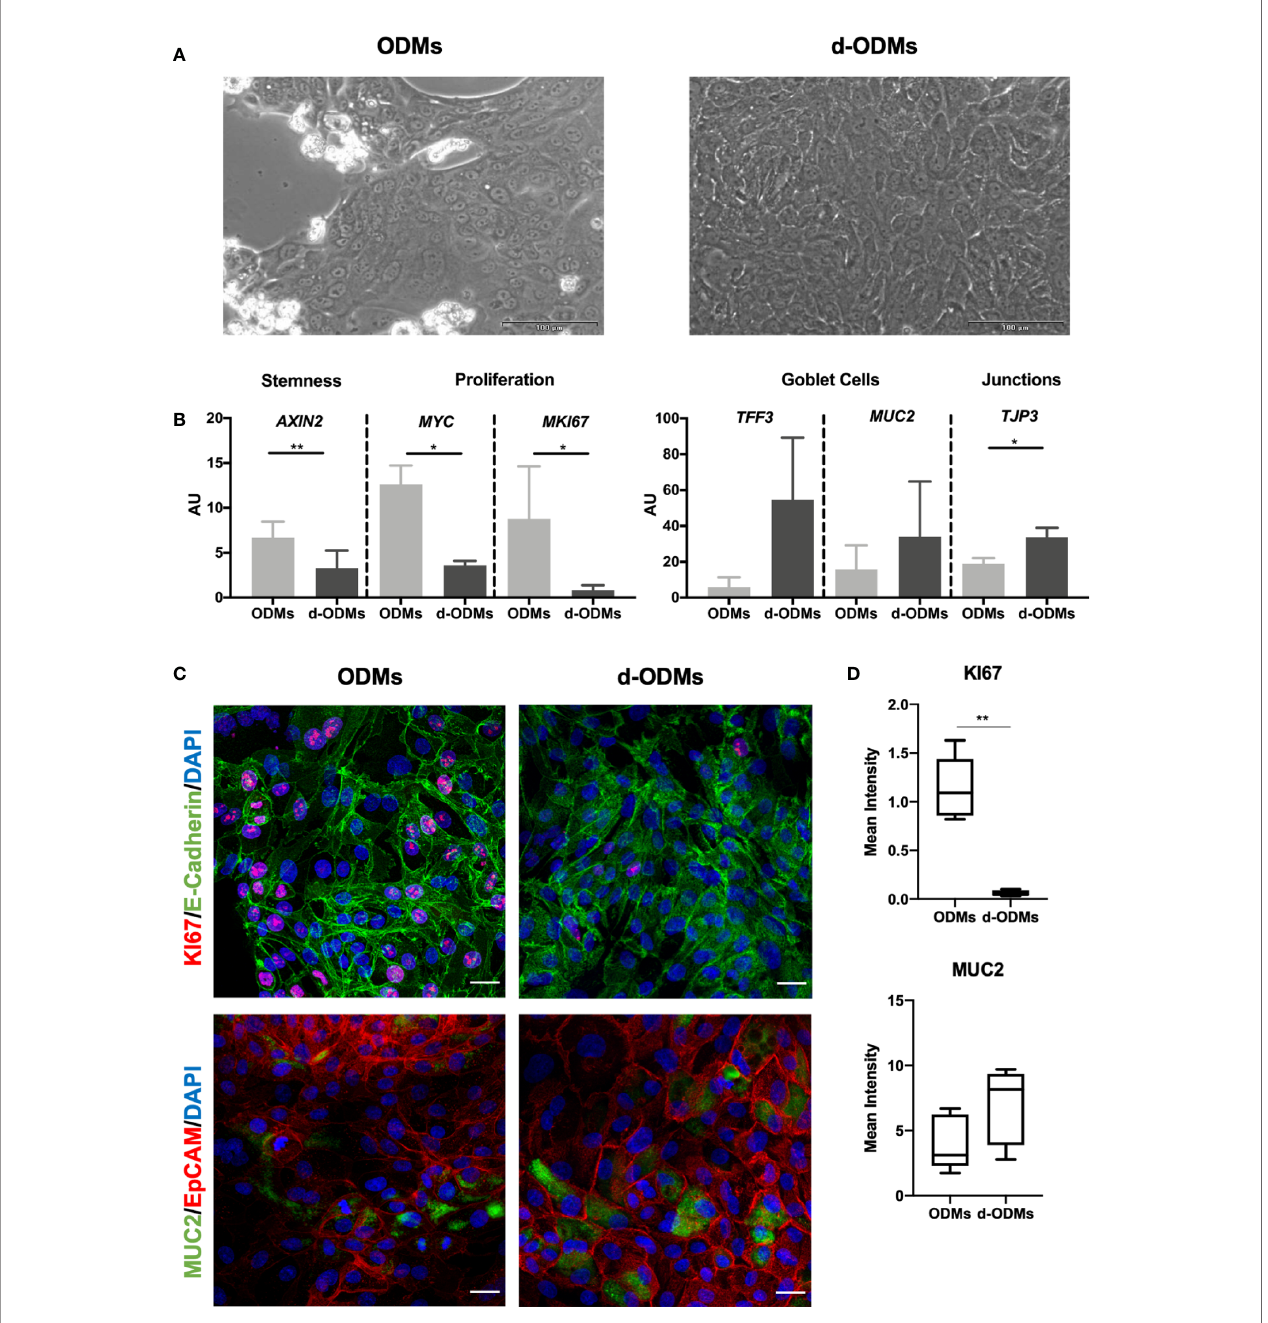
FIGURE 2 | Organoid-Derived Monolayers (ODMs) characterization. (A) ODMs (left panel) 24 hours after seeding showed a con fl uence of around 70-80% and d- ODMs (right panel) 48 hours after differentiation, showed 100% con fl uence. (B) Gene expression analysis of ODMs and d-ODMs (n = 5 for each culture type). AXIN2, MYC, MKI67, TFF3 , MUC2 and TJP3 genes were analyzed by qPCR to determine their expression levels in ODM vs. d-ODMs. A paired t-test was performed to examine statistically different expression patterns between the two groups (ODMs/d-ODMs). A P value of <0.05 was considered statistically signi fi cant. AXIN2 : **indicates P = 0.0012. MYC : *indicates P = 0.0135. MKI67 : *indicates P = 0.0335. TJP3 : *indicates P = 0.0365. (C) Protein expression analysis by immuno fl uorescence. KI67 and MUC2 were analyzed to con fi rm the proliferation and differentiation status of both ODMs and d-ODMs. E-Cadherin and EpCAM were used as epithelial cell-wall markers. DAPI was used to counterstain the cell nuclei. Scale bars: 25µm. Images are representative of n = 3 independent experiments performed with samples from two different donors. (D) Box-plot distribution of the fl uorescent signal of KI67 and MUC2 proteins in ODMs and d-ODMs, expressed as Mean Intensity. Fluorescence was quanti fi ed in 5 different fi elds per sample. A paired t-test was performed to examine statistically different expression patterns between the two groups (ODMs/d-ODMs). A P value of <0.05 was considered statistically signi fi cant. KI67: **indicates P =